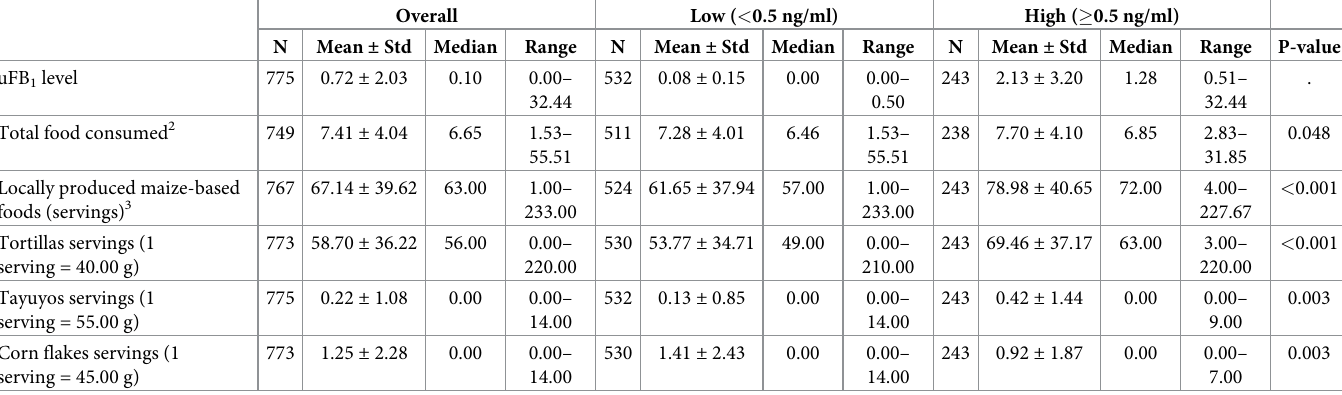
Table 2. Total estimated weekly food consumption (kg), mean, median and range of number of servings consumed for selected food groups and maize-based food items per week overall and by uFB 1 level (ng/ml) 1 � .